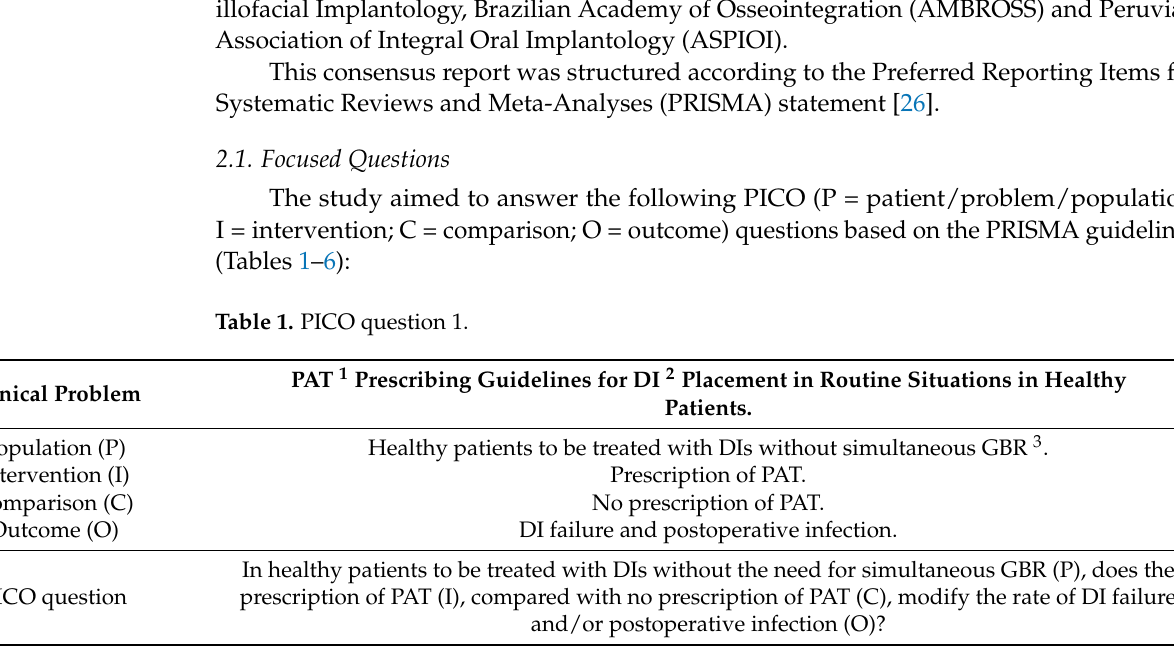
Table 2. PICO question 2.